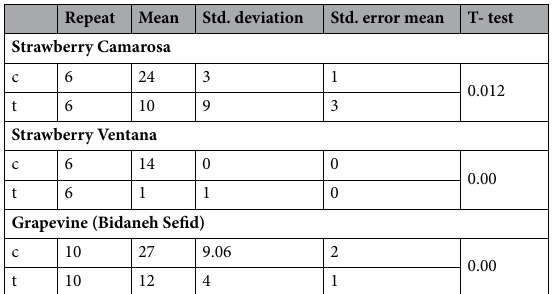
Repeat Mean Std. deviation